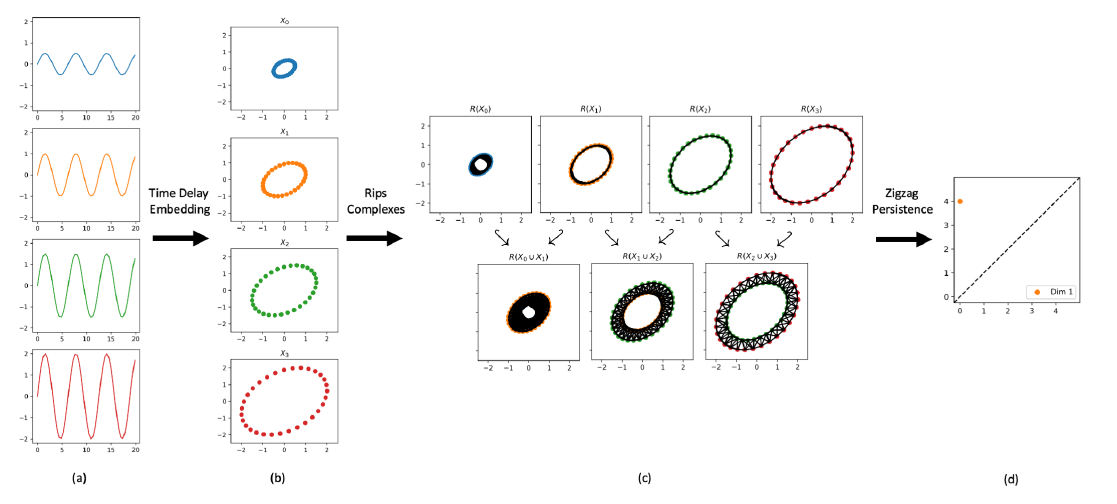
Figure 2. Outline of the Bifurcations using Zigzag (BuZZ) method. ( a ) the input time series; ( b ) the corresponding point clouds embedded via time-delay embedding; ( c ) the zigzag of Rips complexes constructed as described in Section 2.3; ( d ) the corresponding zigzag persistence